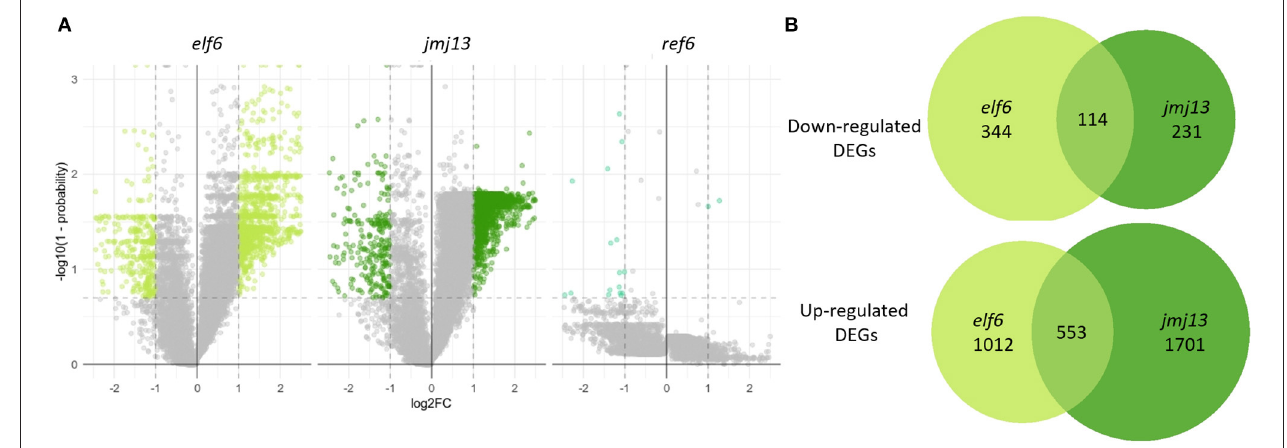
FIGURE 3 | Transcriptome changes in the bud in elf6, ref6 and jmj13 knock-out mutants compared to Col-0. (A) Transcriptomes of elf6, jmj13, and ref6 buds compared after differential expression analysis against the transcriptome of Col-0 buds. The significance thresholds drawn in dashed lines represent a 2-fold change in expression and a probability score > 0.8. Genes over these thresholds are classed as differentially expressed and colored in lime green, forest green and cyan dependent on the genotype. (B) DEGs extracted from the elf6 and jmj13 transcriptomes. They are split into up and down regulated DEGs and represented as individual venn groups, with the shared group representing genes that are either differentially up or down regulated in both elf6 and jmj13 buds compared to